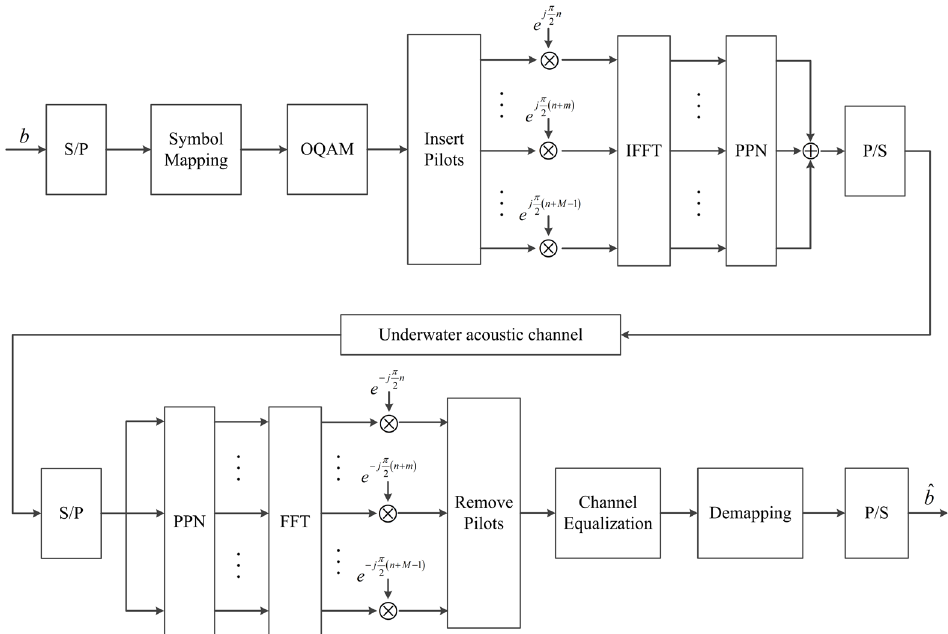
Figure 1. System model of traditional FBMC communications.